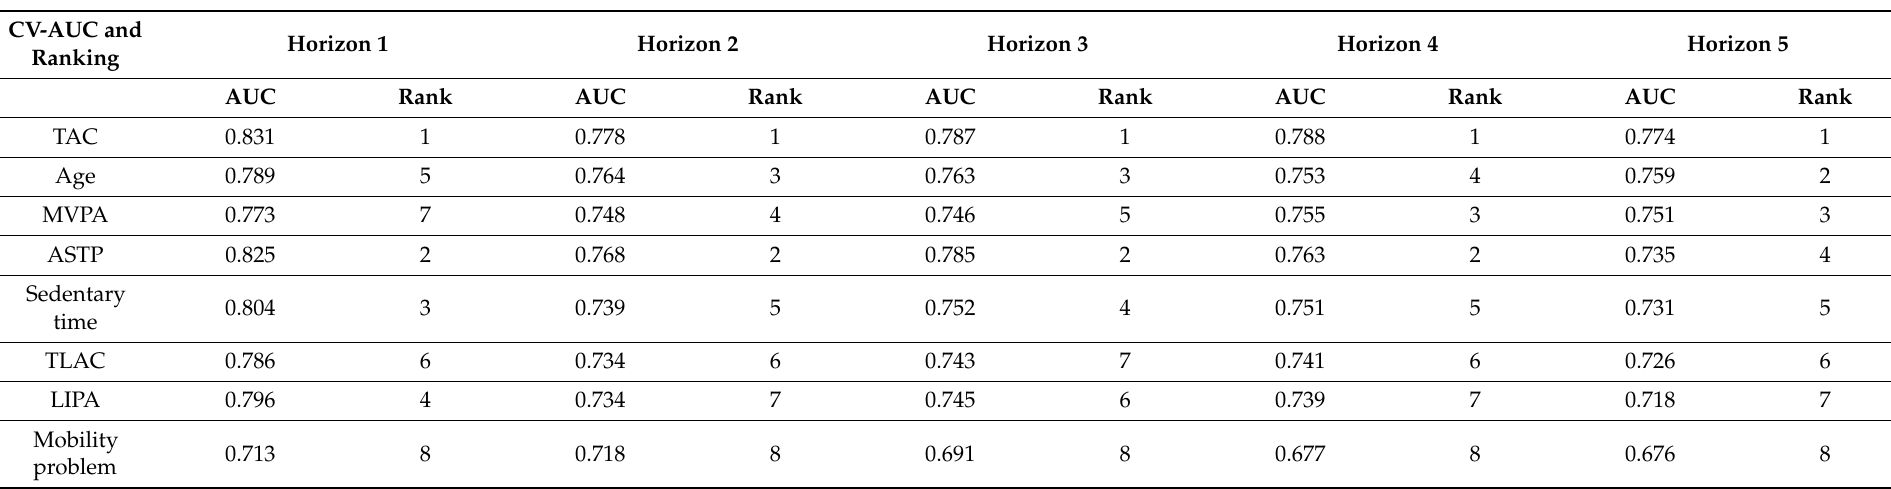
Table A2. Univariate cross-validated AUC for each prediction horizon. The variables are ranked according to year 5